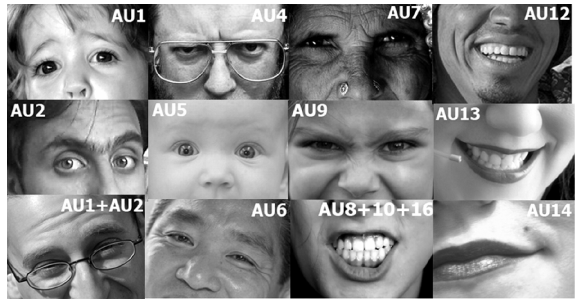
Figure 4. Examples of Action Units. Henceurce: